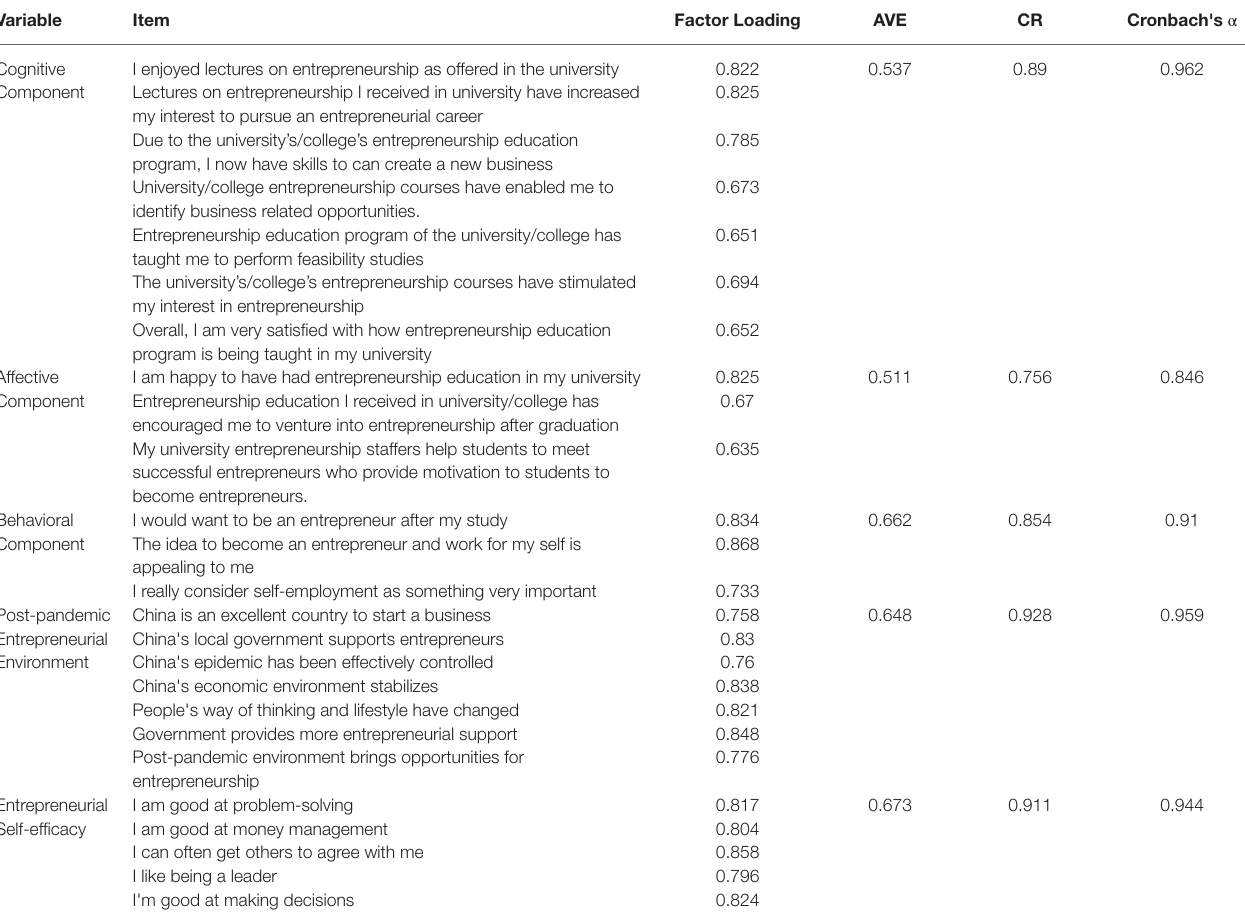
TABLE 1 | Confirmatory factor analysis and reliability